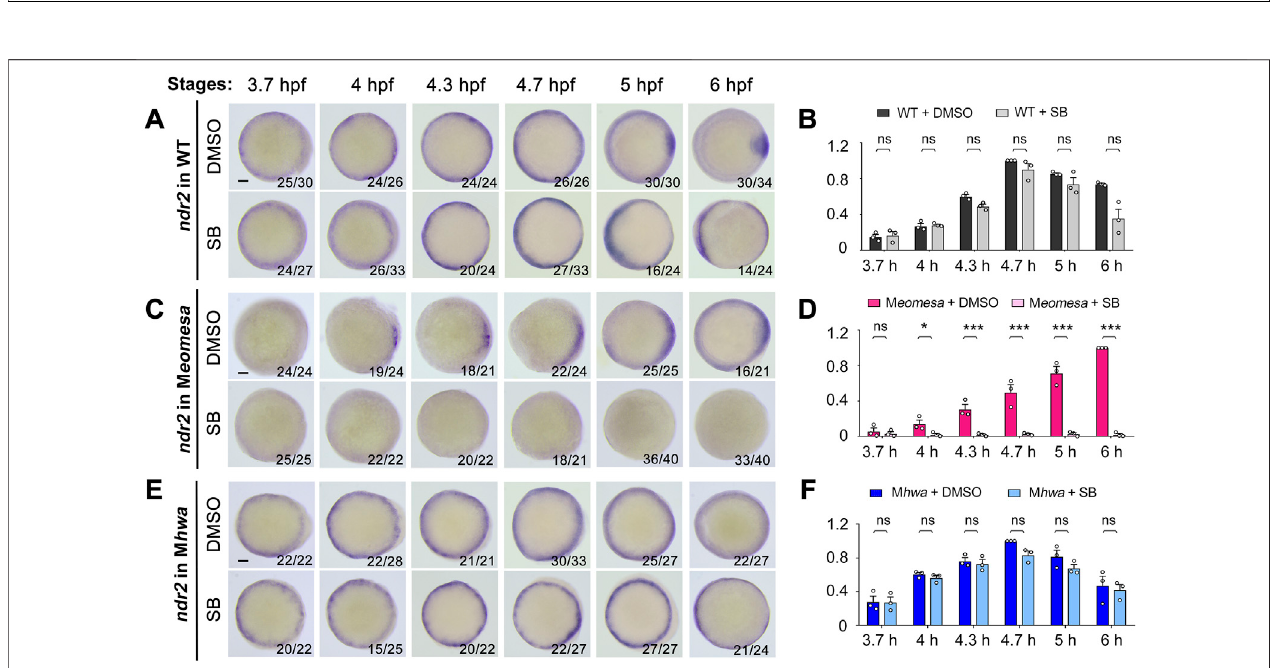
FIGURE 7 | Effect of Nodal signaling inhibition on ndr2 expression in WT and mutant embryos. Embryo treatment and data presentation were similar to those described in Figure 6 legend.